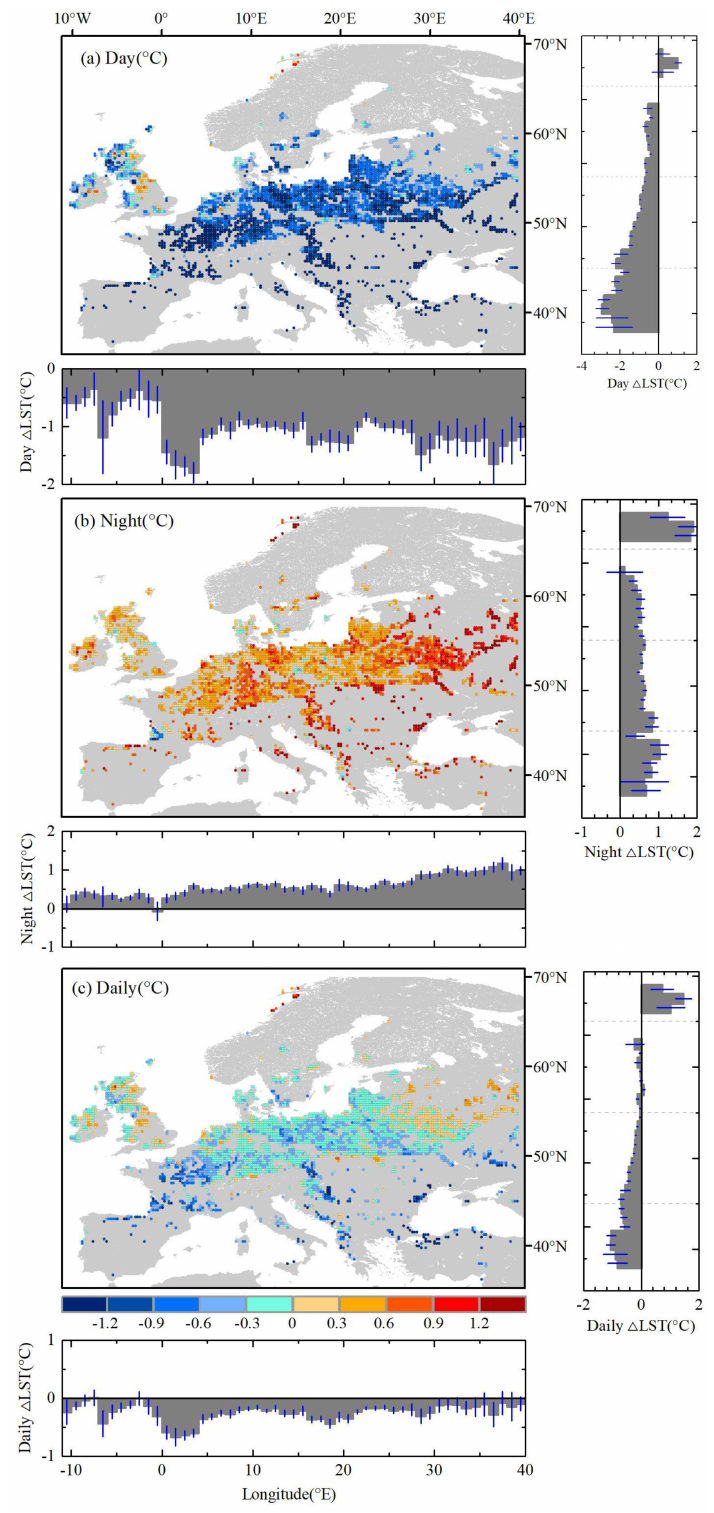
Figure 2. The spatial distributions of the annual mean ( a ) daytime, ( b ) nighttime and ( c ) daily average ∆ LST (forest minus open land) in Europe during the period 2003–2016. The small panels in the below and right of each ∆ LST show the longitudinal and latitudinal zonal average of each ∆ LST for every 1 ◦ bin. The blue lines represent the 95% confidence interval (CI) estimated by the